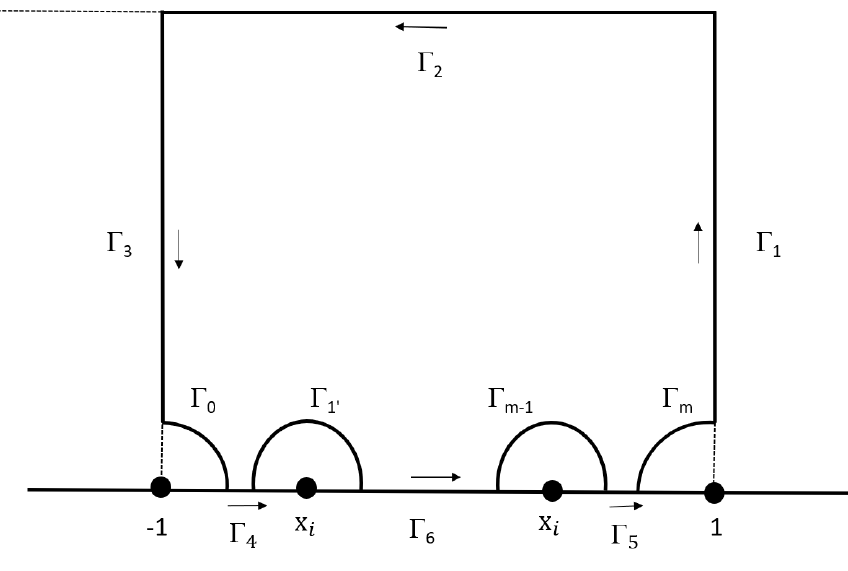
Figure 1. The integration path for integral I [ g ]